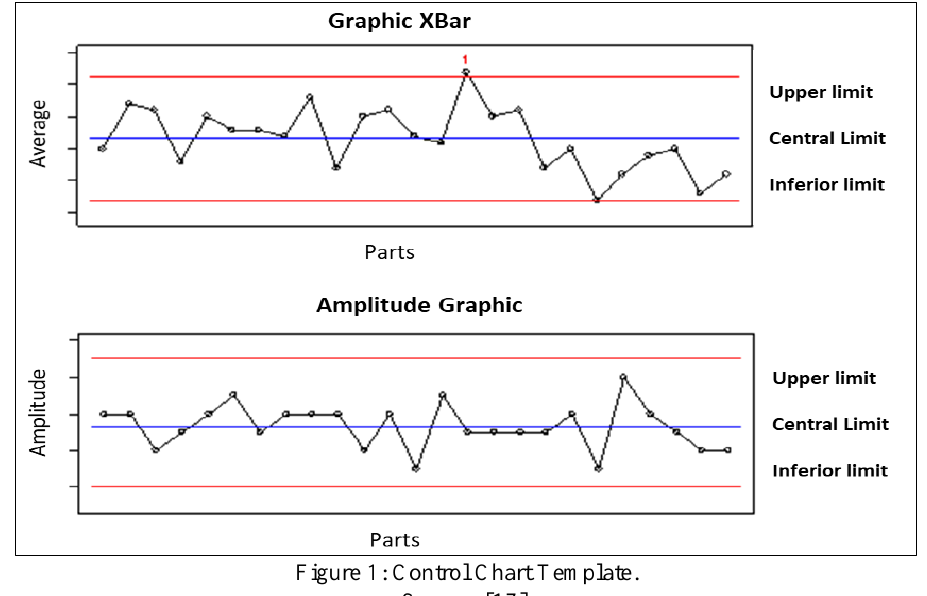
Figure 1: Control Chart